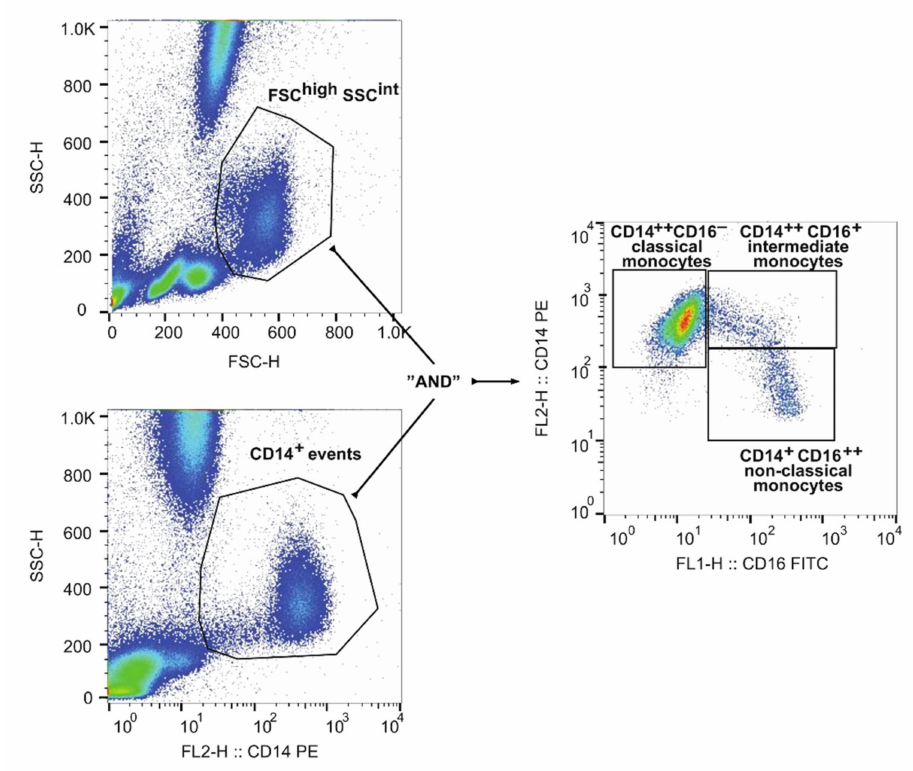
Figure 1. Gating strategy of monocyte analysis with the use of flow